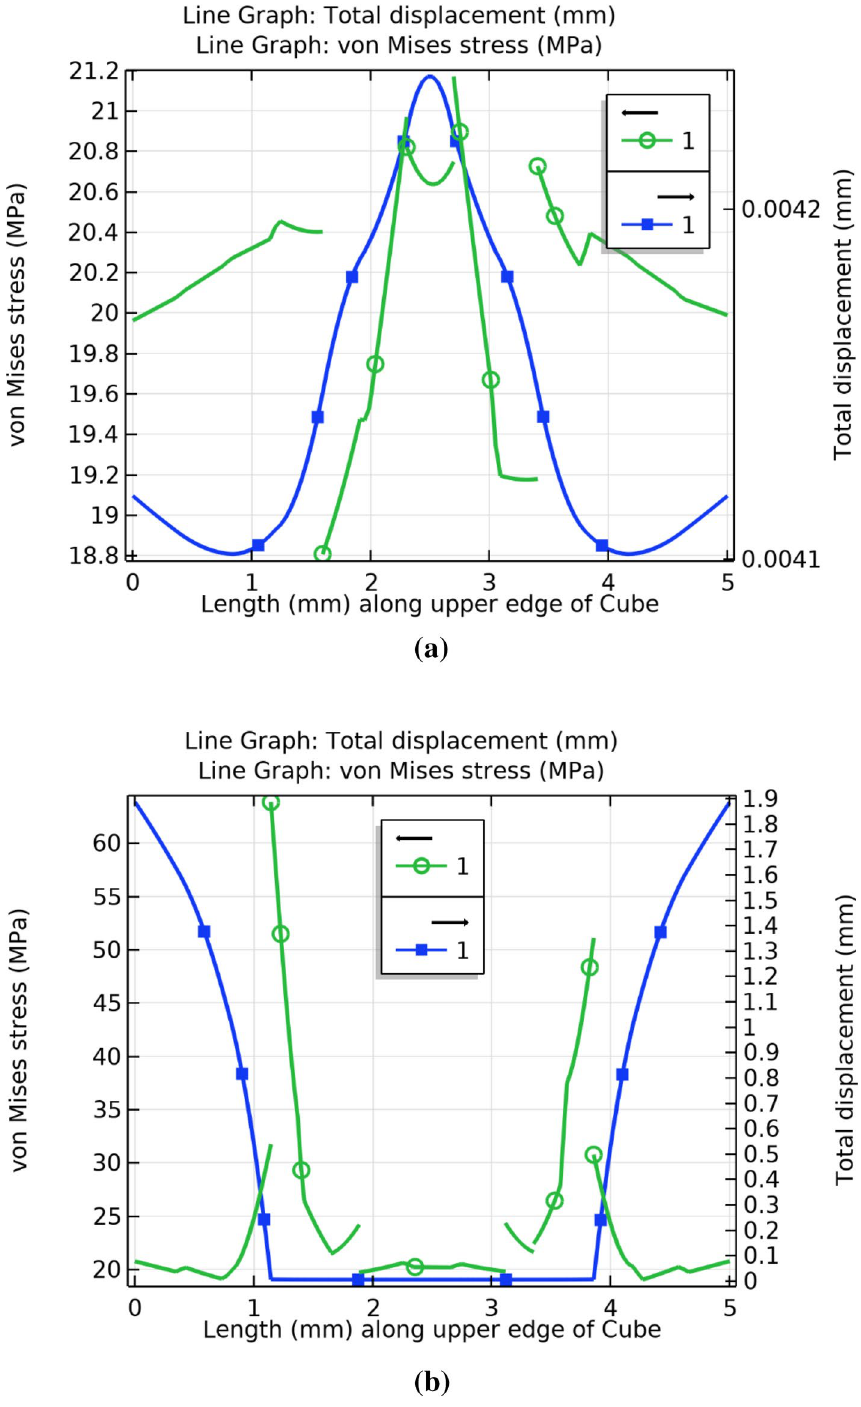
Figure 13. Von-Mises stress and total displacement along the upper edge of ( a ) Concrete ( b ) Green CBC representative